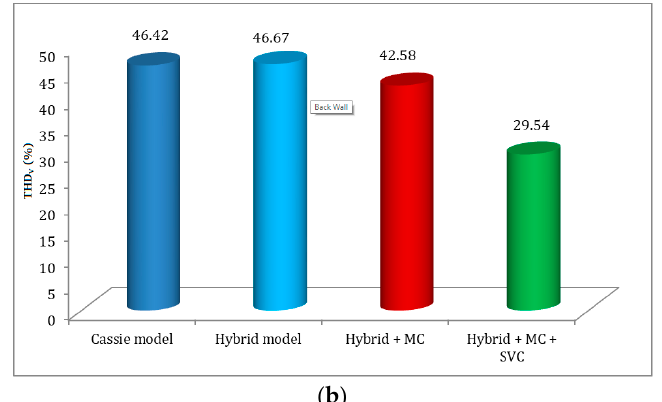
Figure 16. ( a ) V peak in Volts ( b ) THD V (%).